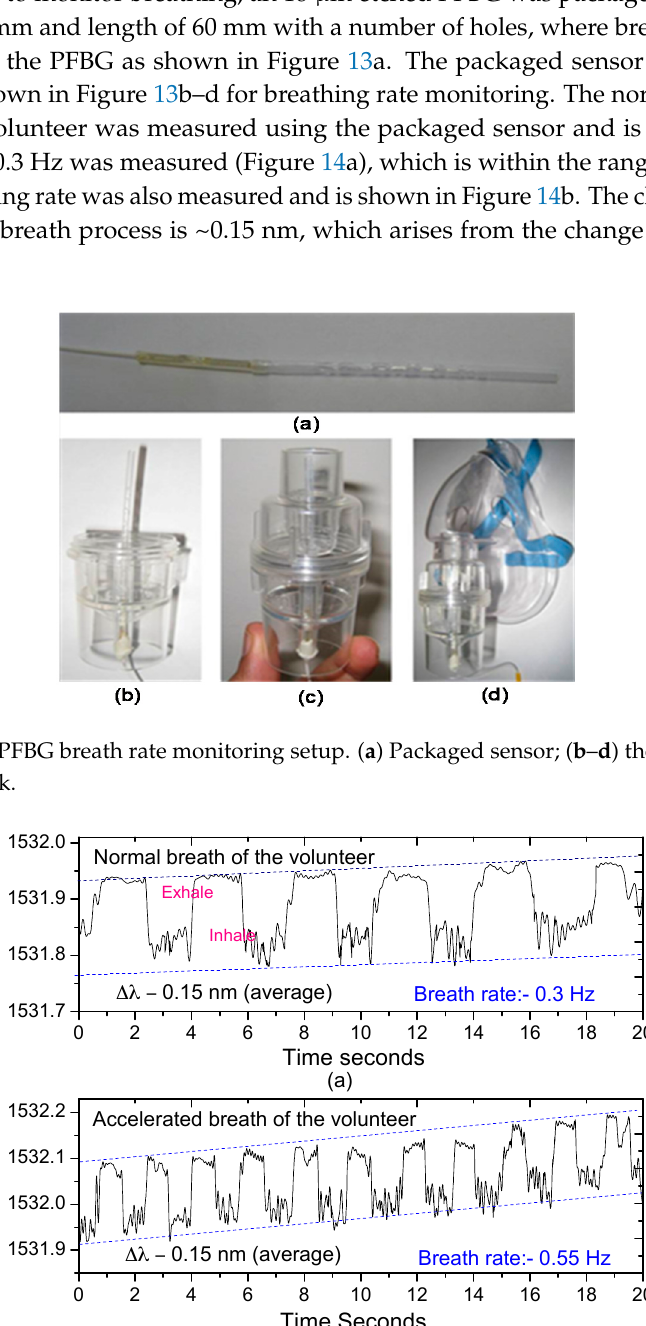
Figure 14. Breathing pattern of a volunteer measured by the etched PFBG sensor. ( a ) Normal breathing; ( b ) accelerated breathing.